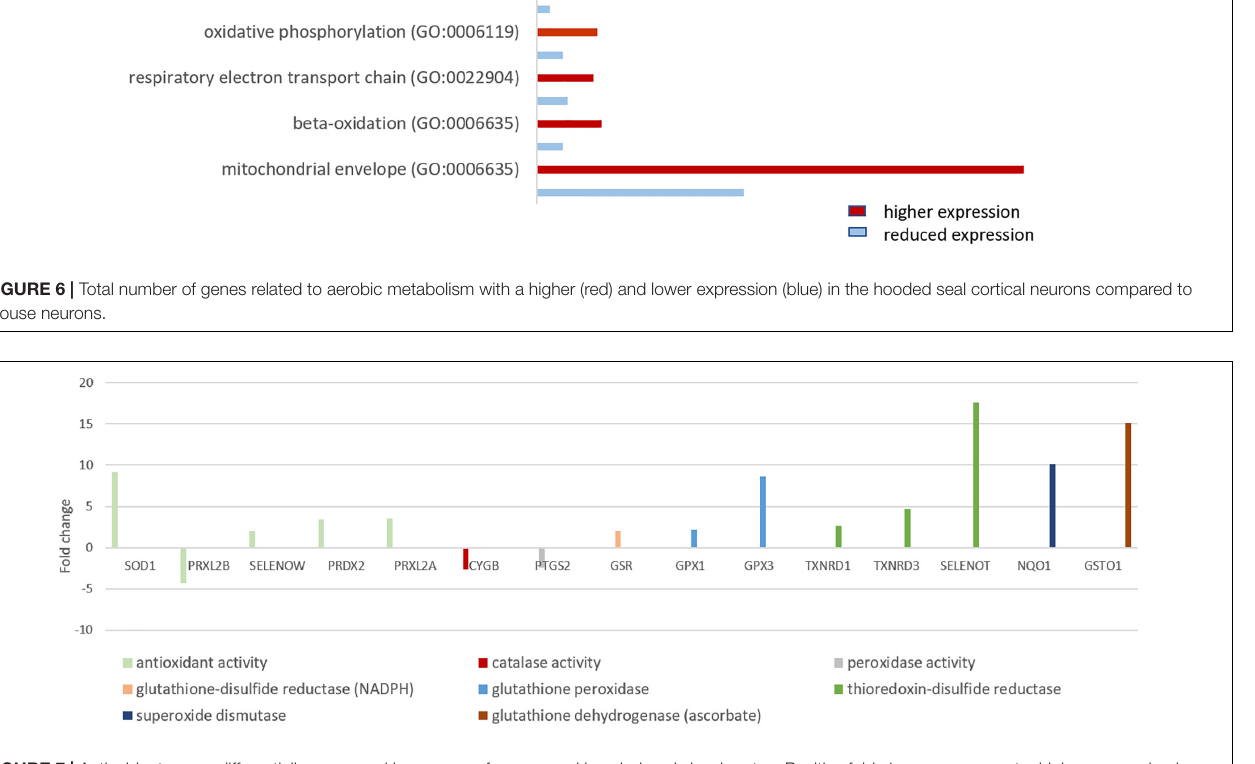
Frontiers in Molecular Neuroscience |